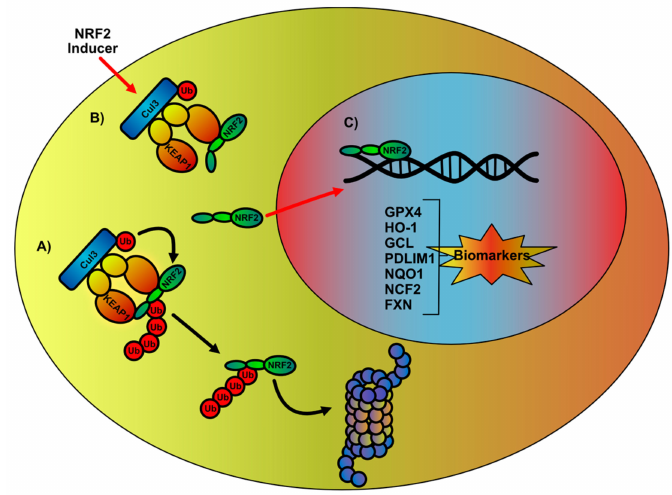
Figure 2. Regulation of NF-E2 p45-related factor 2 (NRF2) transcription pathway and evaluation of potential biomarkers in Friedreich’s ataxia. ( A ) In normal conditions, NRF2 is located in the cytoplasm and complexed to a Kelch-like ECH-associated protein 1 (KEAP1) homodimer, which in conjunction with Cullin3 (CUL3) determines the sequential addition of ubiquitin (Ub) monomers, leading to NRF2 polyubiquitination and proteasome-mediated degradation. ( B ) Upon ROS and / or specific compounds mediated induction, conformational changes in KEAP1 structure disrupt KEAP1 interaction with the NRF2 Neh2 domain DLG motif, impairing NRF2 polyubiquitination. This allows newly